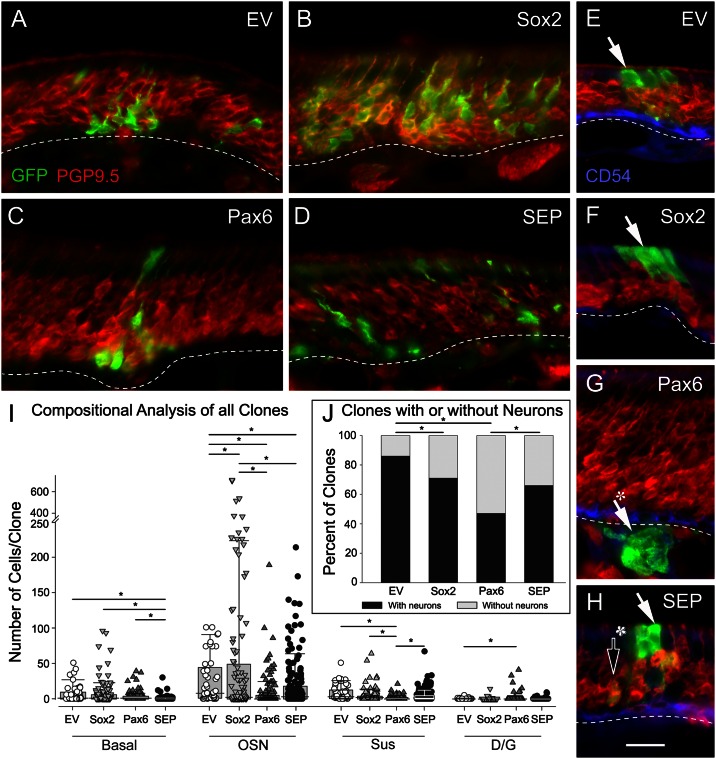
Pax6- and Sox2-encoding retroviral vectors differentially alter the cellular composition across clones.(A-H) Tissues harvested 3 weeks after EV, Pax6, SEP and Sox2 RVV-transduction were stained with GFP, along with PGP9.5 (a neuronal marker) to illustrate the range in outcomes for each condition. Cell identity among clones was then determined relative to PGP9.5 staining. GFP-labeled cells were identified as sustentacular cells (Sus) when their cell bodies were found superficial to the band of PGP9.5 (+) OSNs, while GFP-labeled cells were identified as basal cells if they were deep to the band of neurons. GFP (+) cells were identified as duct/gland cells (D/G) when they were flattened, oriented as a chain of cells along the apical-basal axis, and/or extended deep to the basal lamina into the lamina propria (cf. Fig 3G and 3H). GFP (+) cells were identified as OSNs, if they co-labeled with PGP9.5. (E-H) CD54 was used to immunostain HBCs along with PGP9.5. (E-H) There is substantial variation in clonal composition. (E) The arrow indicates a mixed clone composed of OSNs and a large group of Sus cells atop the neurons. (F) The arrow indicates a Sus-only clone where the GFP-labeled cells sit atop the neurons. (G) The solid arrow with asterisk points to gland cells located deep to the HBCs and basal lamina. (H) Another example of a mixed clone composed of Sus cells (arrow) and neurons (hollow arrow with asterisk). Dashed lines mark the basal lamina (A-H) and the scale bar in (H) corresponds to 20 μm and applies to all of the panels. (I) For the various cell types, the data from each and every clone was used to generate a box-and-whiskers scatter plot; the median for each distribution is marked by the horizontal black line within the box. In the order shown in the graph they are: for basal cells– 1, 1, 1, 0; for OSNs– 8, 2, 0, 3; for Sus cells– 3, 2, 0, 1; for D/G (duct/gland cells)– 0, 0, 0, 0, respectively. Note the break in the ordinate of the graph to accommodate those clones that contain a markedly greater number of neurons, which occur exclusively with Sox2 transduction. Because all of the datasets shown here failed the Shapiro-Wilk test for normality, a Kruskal-Wallis One-Way ANOVA on Ranks was used, followed by Dunn’s Method for pairwise multiple comparisons. (J) For the group of clones as a whole, the percentage of clones that contain neurons for each form of transduction are indicated in the bar graph, and multiple pairwise comparisons (indicated by the horizontal lines) are significantly different (Fisher Exact test with Holm-Sidak multiple comparison correction, * p < 0.05).